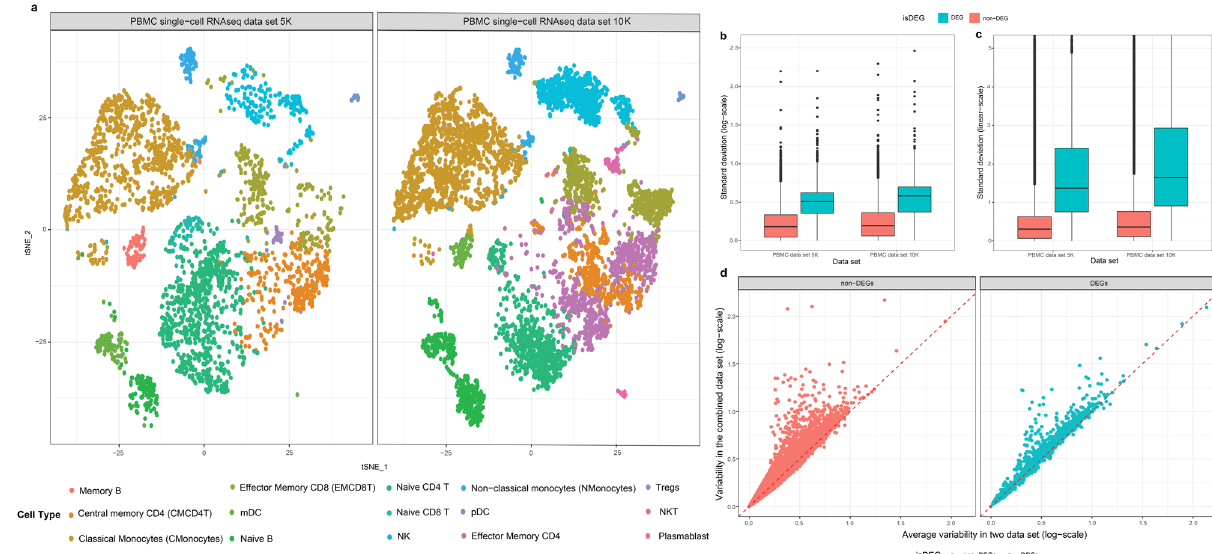
Fig. 1 Overview of single-cell CITE-seq data from two PBMC samples. a t-SNE plots show the similarities in Pearson correlation coef fi cients among gene expression pro fi les of individual cells in two single-cell PBMC RNA-seq data, respectively, on the left and right. Cell type* is denoted by color. b , c Comparison of gene expression variability measured in standard deviation ( y -axis) per gene and cell type pair in log-scale ( b ) and linear-scale ( c ) for both datasets (x- axis). The genes were split by differentially expressed genes (DEGs; n = 2876 gene and cell type pairs; red) and non-differentially expressed genes (non- DEGs; n = 145,305 gene and cell type pairs; blue). The standard boxplot notation was used (lower/upper hinges — fi rst/third quartiles; whiskers extend from the hinges to the largest/lowest values no further than 1.5 * inter-quartile ranges). d . Comparison of within-sample ( x -axis) and between-sample variability ( y - axis) in gene expression levels per cell type, split by DEGs ( n = 2876) and non-DEGs ( n = 145,305) per cell type. Standard deviation is measured for each gene and cell type fi rst separately in two PBMC single-cell datasets followed by taking the average ( x -axis), then also in merged PBMC data set ( y -axis). Only the nine cell types commonly detected in two data sets were used in the analysis. *(CMCD4T: central memory CD4 + T cell; CMonocytes: classical monocytes; EMCD4T: effector memory CD4 + T cell; mDC: myeloid dendritic cell; MemoryB: memory B cell; MemoryCD8T: memory CD8 + T cell;